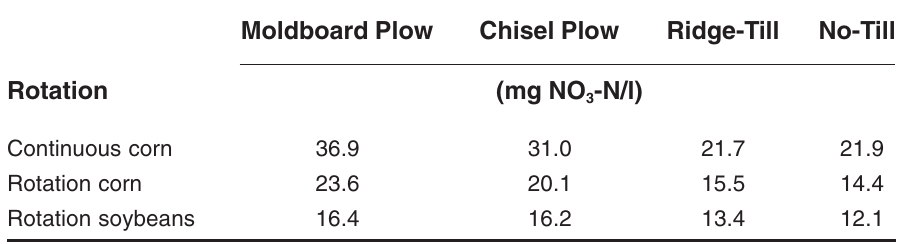
NO -N Concentrations in Tile Drainage as Affected by Crop Rotation 3